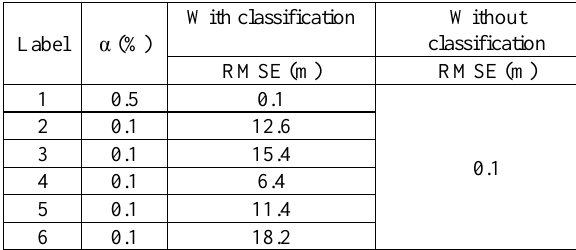
Table 6. The RMSEs with and without classification